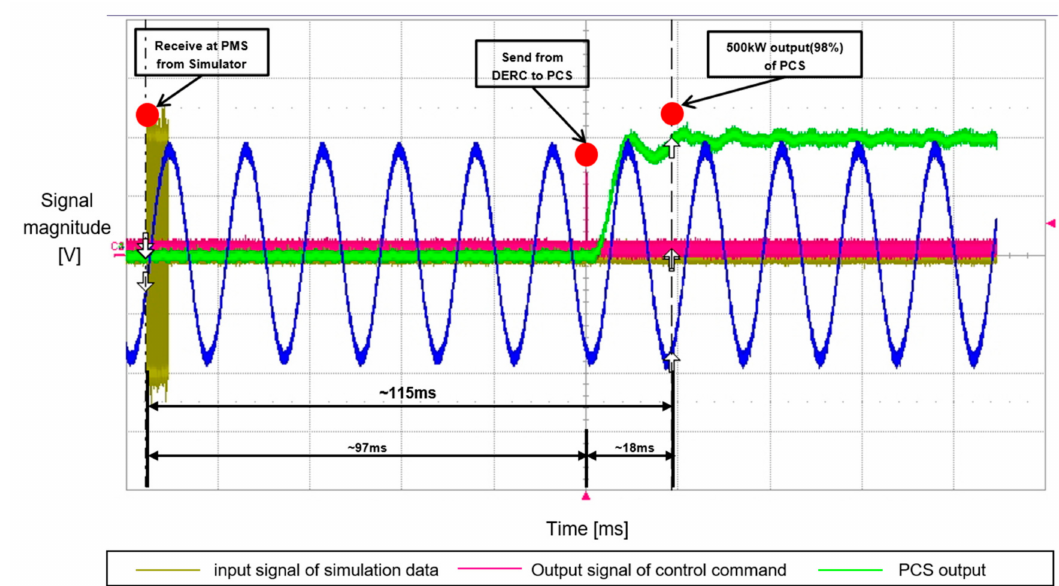
Figure 13. Results of time performance test for verification of the proposed system.